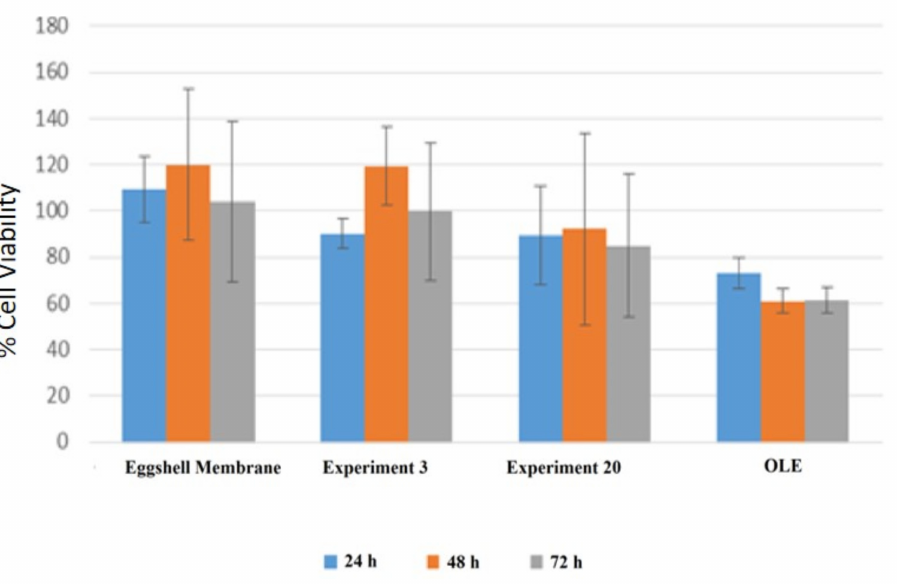
Figure 11. Cytotoxic activity of the OLE-loaded eggshell membrane on 3T3 cell. The effect of OLE and OLE-loaded eggshell membrane on the viability of the 3T3 cells was investigated. In Figure 11, the incubation of OLE-loaded eggshells with cells at different time intervals is coded with colors. Blue bars represent 24 h incubation, brown bars represent 48 h incubation, and gray bars represent 72 h incubation. Besides, the margins of error in the calculated cell viability analysis are indicated as a line graph above the bars. The x-axis of the graph shows the eggshell, eggshell-OLE mixes prepared with the factors indicated in Table 2 (sample number 3 and 20), and pure OLE. The parameters used in the preparation of sample number 3 were the following: acetic acid concentration “0%”, eggshell size “2 mm”, time spent in column “1 h”, and average air flow velocity in column “0.1 cm/s”. The eggshell and membrane separation efficiency of sample number 3 is 38%. The parameters used in the preparation of sample number 20 were the following: acetic acid concentration “50%”, eggshell size “2 mm”, time spent in column “3 h”, and mean air flow velocity in column “0.3 cm/s”. The eggshell and membrane separation